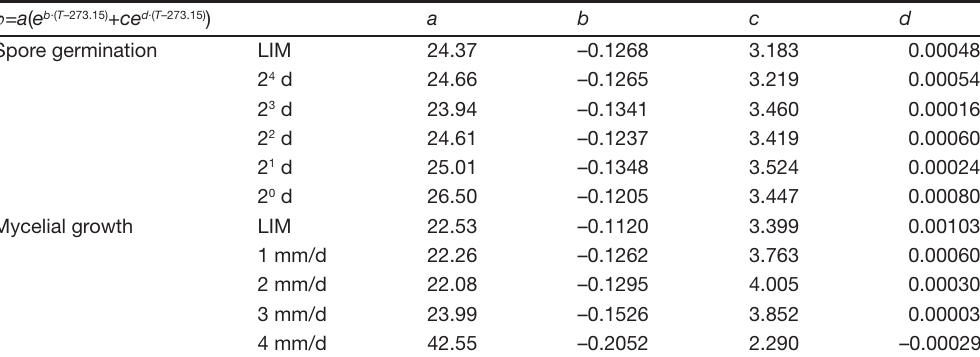
Table 2. Coefficients for the equations in the isopleth system